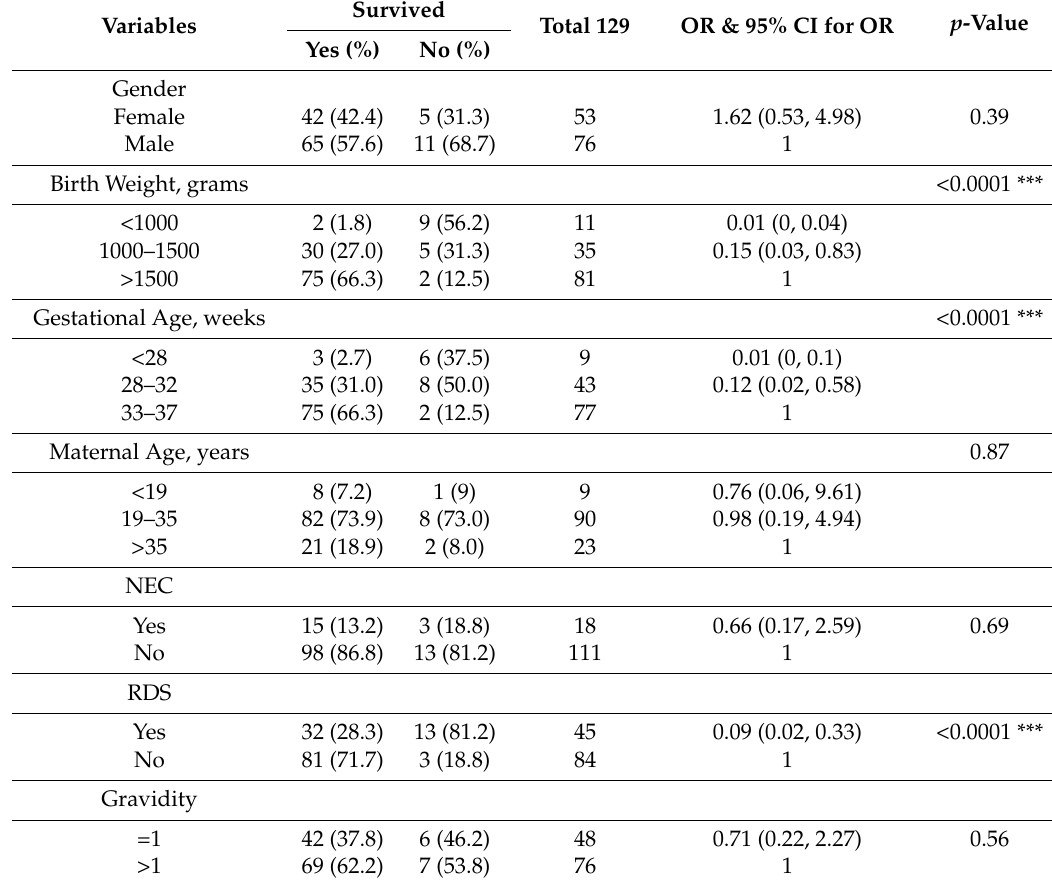
Table 3. Univariate analysis of base characteristics to assess predictors of preterm neonatal mortality.